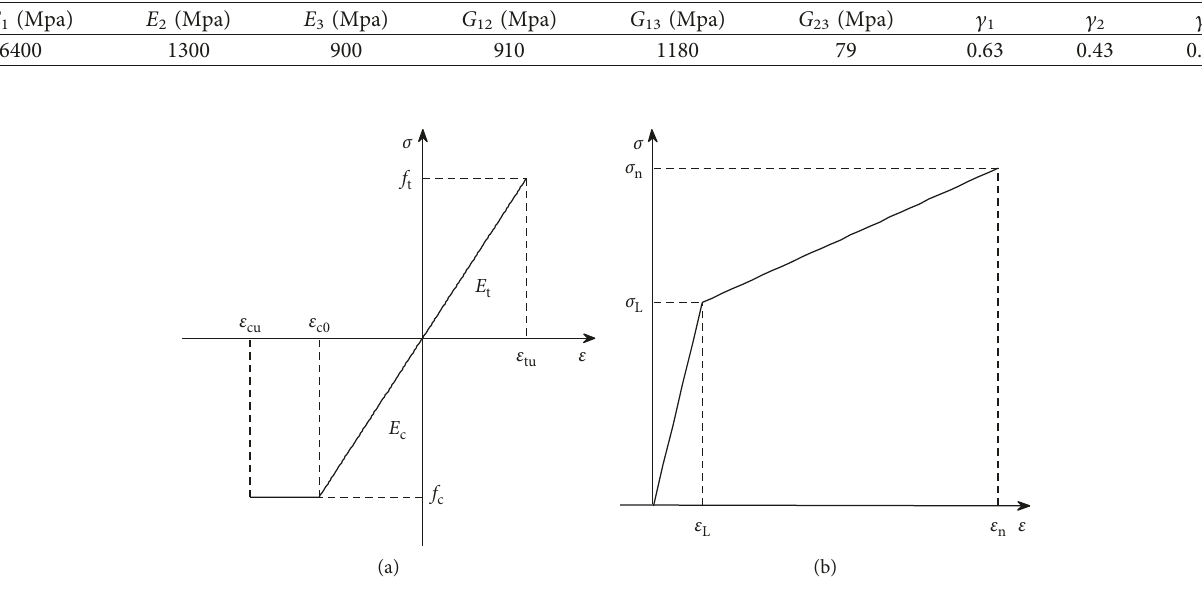
Figure 13: Stress-strain constitutive model for materials in the specimens. (a) Parallel-to-grain direction. (b) Perpendicular-to-grain